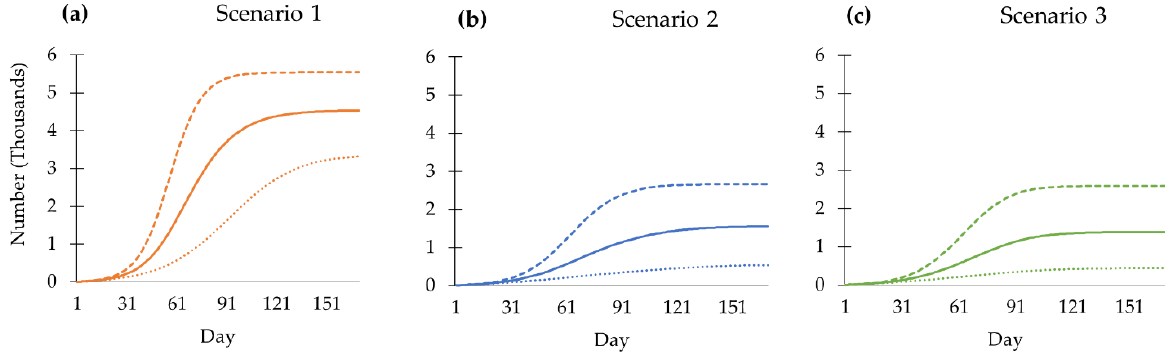
Figure 4. Cumulative deaths of all scenarios from day 1 to day 170: ( a ) Scenario 1, no booster dose; ( b ) Scenario 2, viral vector vaccine as booster dose; ( c ) Scenario 3, mRNA vaccine as the booster dose. The solid line shows the mean of the outcome. The dashed line shows the 97.5th percentile of the outcome. The dotted line shows the 2.5th percentile of the outcome.